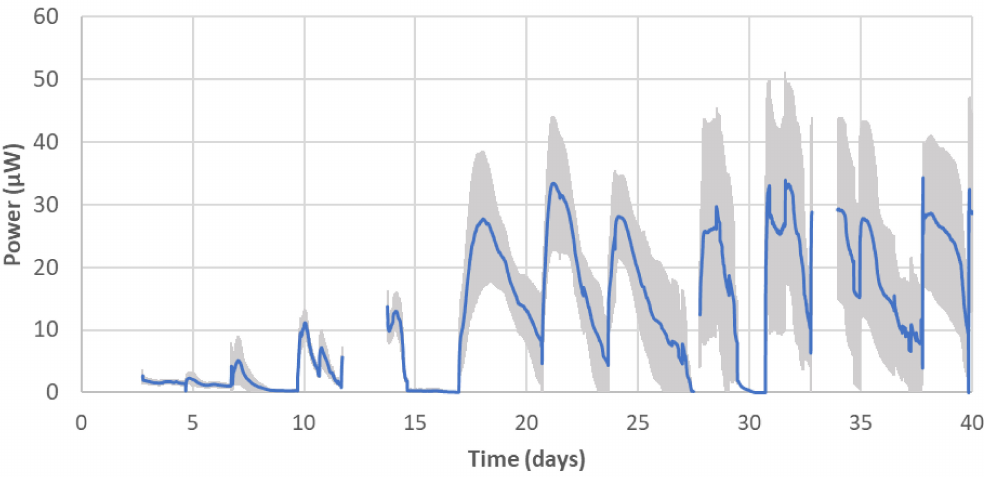
Figure 4. Power output of AM-built MFCs. Data points are average values of 16 MFCs. Sections where the graph line is discontinued indicate when voltage monitoring halted due to either electrochemical analysis or powering electrical devices, except the first three days of the open circuit period. Error bars stand for the standard deviation of the 16